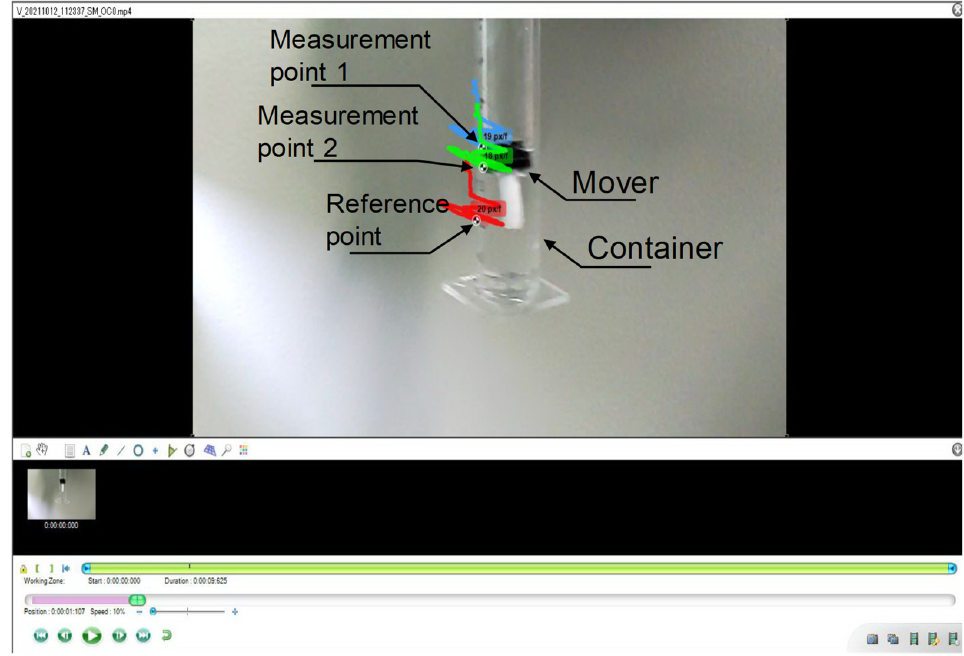
Figure 5. Measurement of the tilt angle of the mover with Kinovea software ver. 0.9.5 by Joan Charmant.